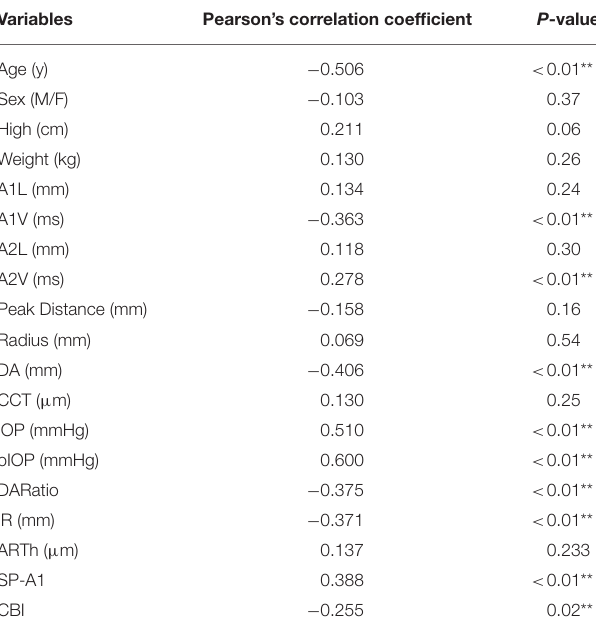
TABLE 3 | Correlation of ACV measured by Casia SS OCT and demographics, corneal biomechanical parameters. Variables